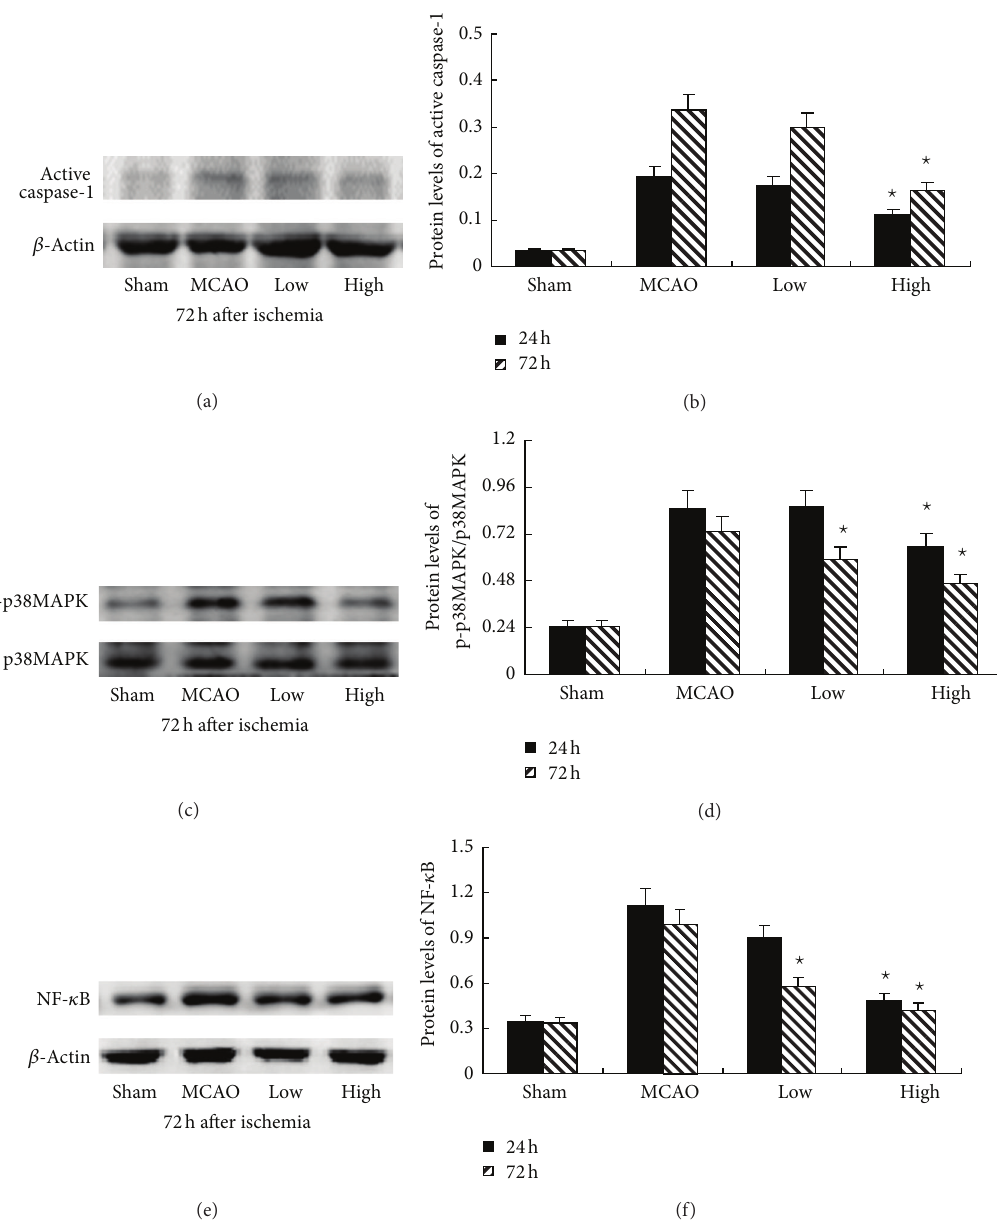
Figure 4: PN decreased protein of active caspase-1, phospho-p38MAPK, and nuclear NF- 𝜅 B p65 after MCAO. (b) shows the expression of active caspase-1. Compared with MCAO group, the expression of active caspase-1 was significantly decreased in High group at 24h and 72 h. (d) shows the expression of phospho-p38MAPK. (f) shows the expression of nuclear protein NF- 𝜅 B. Compared with MCAO group, the expression of phospho-p38MAPK and nuclear protein NF- 𝜅 B was significantly decreased in High group both at 24 h and 72 h, but decreased only at 72h in Low group ⋆ 𝑃 < 0.05 versus MCAO group. Representative photographs in ((a), (c), (e)) show the influence of PN on protein of active caspase-1, phospho-p38MAPK, and nuclear protein NF- 𝜅 B at